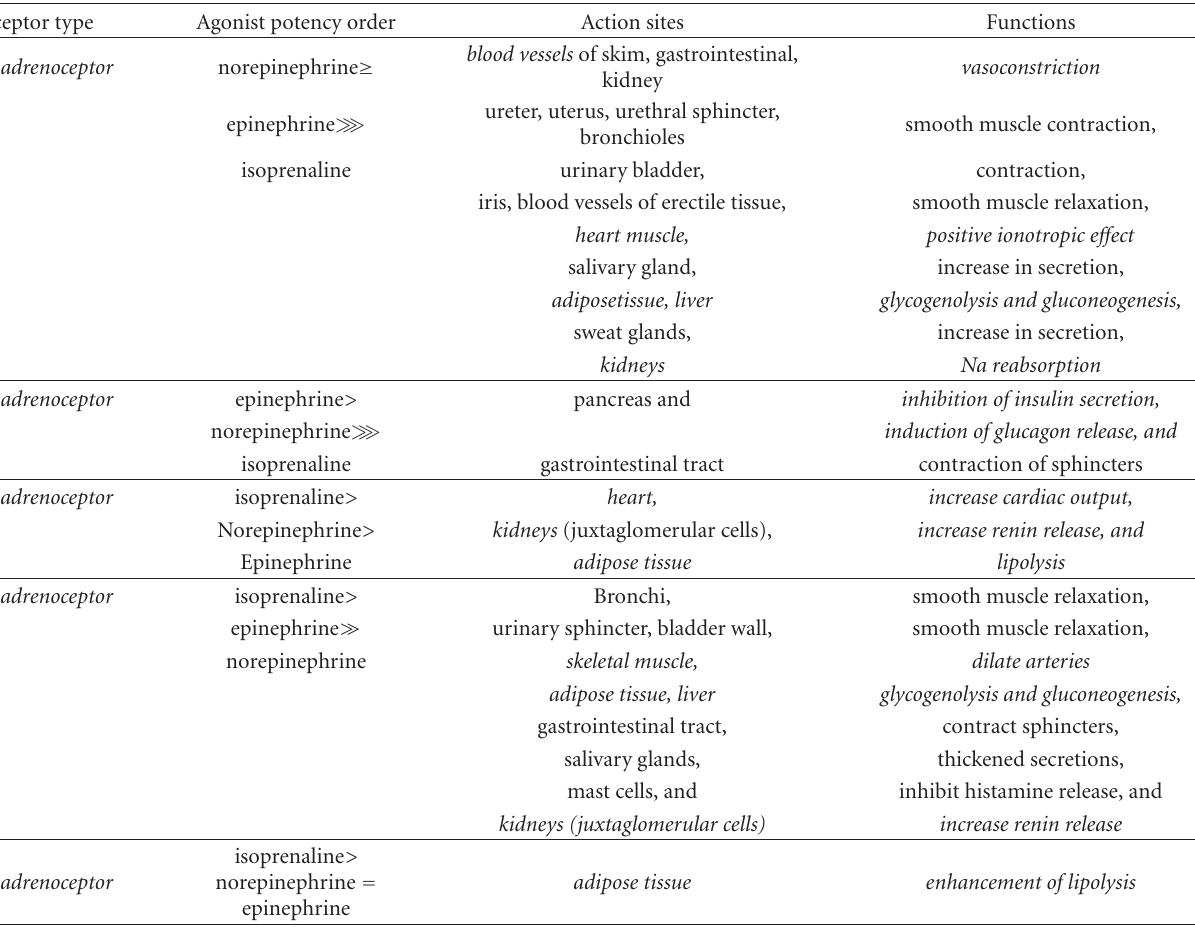
Table 1: Comparisons of adrenergic receptor subtypes.